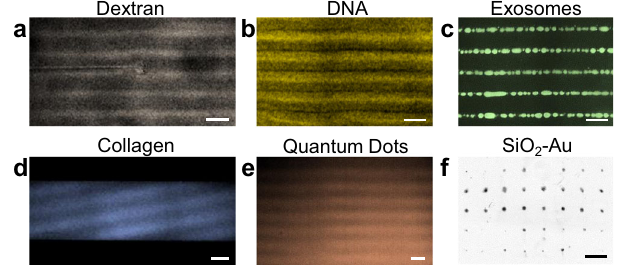
Fig. 3 Manipulation of various nanomaterials and macromolecules via AENT. Patterning of a FITC-dextran (500 kMW), b stained DNA (3 kbp), c fl uorescent urinary exosomes (30 – 150 nm), d FITC-collagen (type-I, 300 nm in length and 1.6 nm in diameter), e quantum dots (~6 nm CdSeS/ZnS), and f ~100 nm SiO 2 -Au particles. The backgrounds of the images have been removed and pseudo-colors are added to enhance visibility for these nanoscale samples. Scale bars: 60 μ m; Collagen: 150 μ